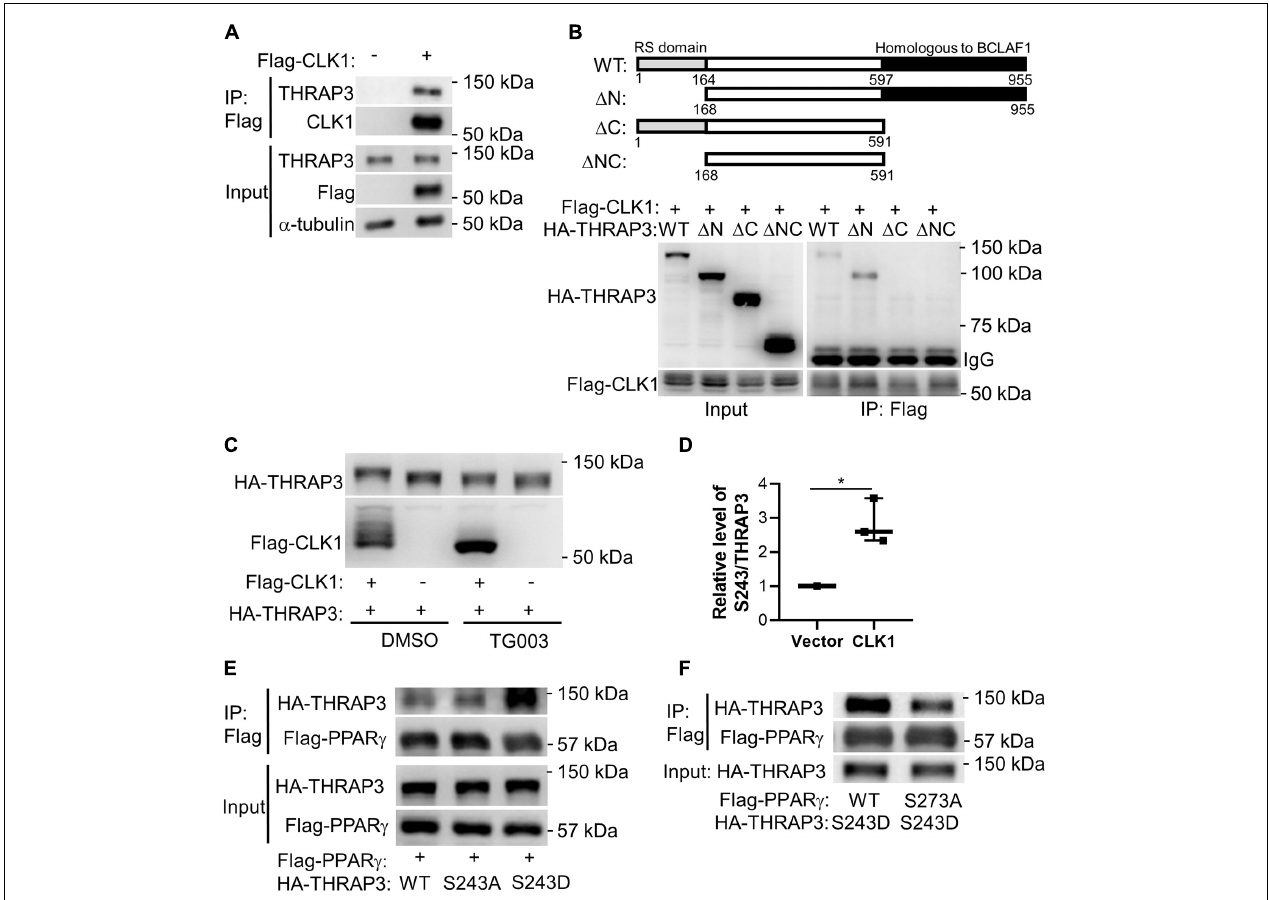
FIGURE 5 | Functional complexes of CLK1-THRAP3-PPAR γ . (A) Flag-tagged CLK1 transfected into HEK293T cells was pulled down with an anti-Flag antibody after 48 h. THRAP3 co-immunoprecipitation (Co-IP) was verified by western blot. (B) Schematic illustration of full length and truncated mutants of THRAP3 (top) . Flag-tagged CLK1 and HA-tagged THRAP3 full length (WT) or truncated mutants ( (cid:49) N, (cid:49) C, or (cid:49) NC) were co-transfected into HEK293T cells and subjected to subsequent immunoprecipitation using anti-Flag antibody. Anti-HA antibody was used to detect THRAP3 bound to CLK1 in the Western blots (bottom) . (C) Co-transfection of Flag-tagged CLK1 and HA-tagged full length THRAP3 into HEK293T cells followed by treatment with the CLK1 inhibitor TG003 (10 µ M) or vehicle control DMSO for 6 h. The cell lysates were collected and subjected to Western blotting. The mobility shift in both THRAP3 and CLK1 in the presence of the CLK1 inhibitor is indicative of increased THRAP3 phosphorylation and CLK1 autophosphorylation in the presence of overexpressed CLK1 without the inhibitor (heavier bands, lane 1). (D) Co-transfection of HA-tagged THRAP3 and Flag-tagged CLK1, or empty vector as control, into HEK293T cells for 24 h was followed by immunoprecipitation with anti-HA monoclonal antibody-conjugated agarose beads. The relative phosphorylation of THRAP3 at Ser243 in the immunoprecipitants was measured by Mass Spectrometry and was normalized relative to the vector control HEK293T cells set as 1. n = 5. * p < 0.05 vs Vector. (Unpaired Student’s t test). (E) HA-tagged phosphorylation-deficient (S243A) or phosphorylation-mimic (S243D) forms of THRAP3 were co-transfected with Flag-PPAR γ into HEK293T cells. Following Flag-mediated Co-IP, their interactions were analyzed by western blotting. (F) HA-THRAP3 S243D mutants were co-expressed with the WT or